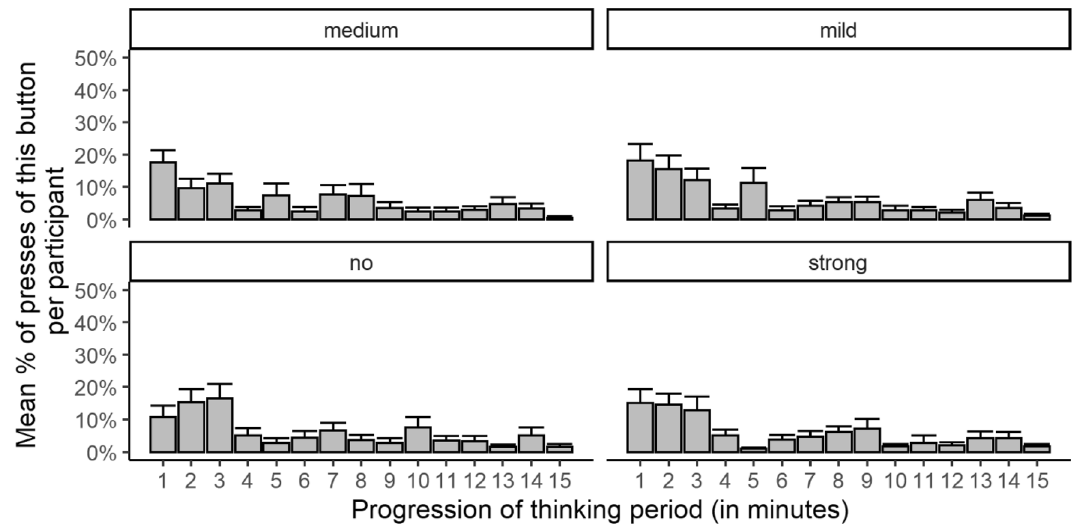
Figure 4. Rate of button presses as a function of time. Error bars show the standard error. Subjects without button presses and two subjects with outlier values were not included in the counts (valid n = 30).